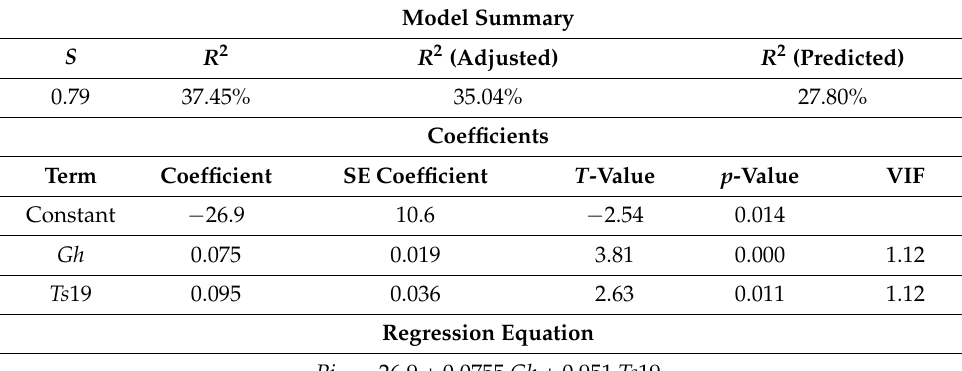
Table 2. Model summary for con-still (Model